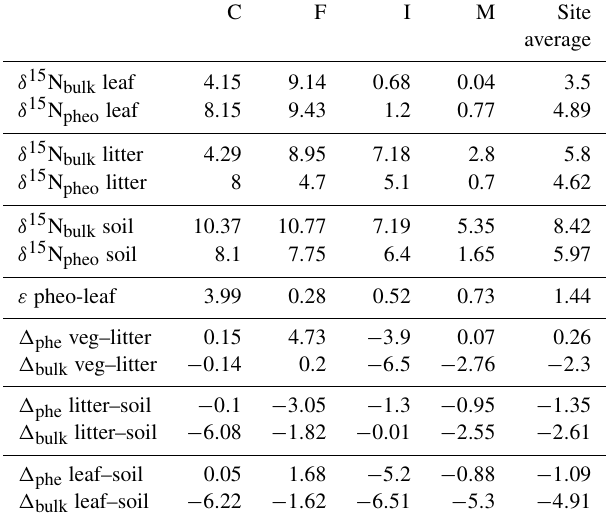
Table 4. Isotope values, offsets between bulk and pheo a δ 15 N val- ues, and differences in pheo a and bulk δ 15 N values across the leaf– soil continuum, across sites. Bulk values are included only for sam- ples for which a corresponding pheo a measurement was made.